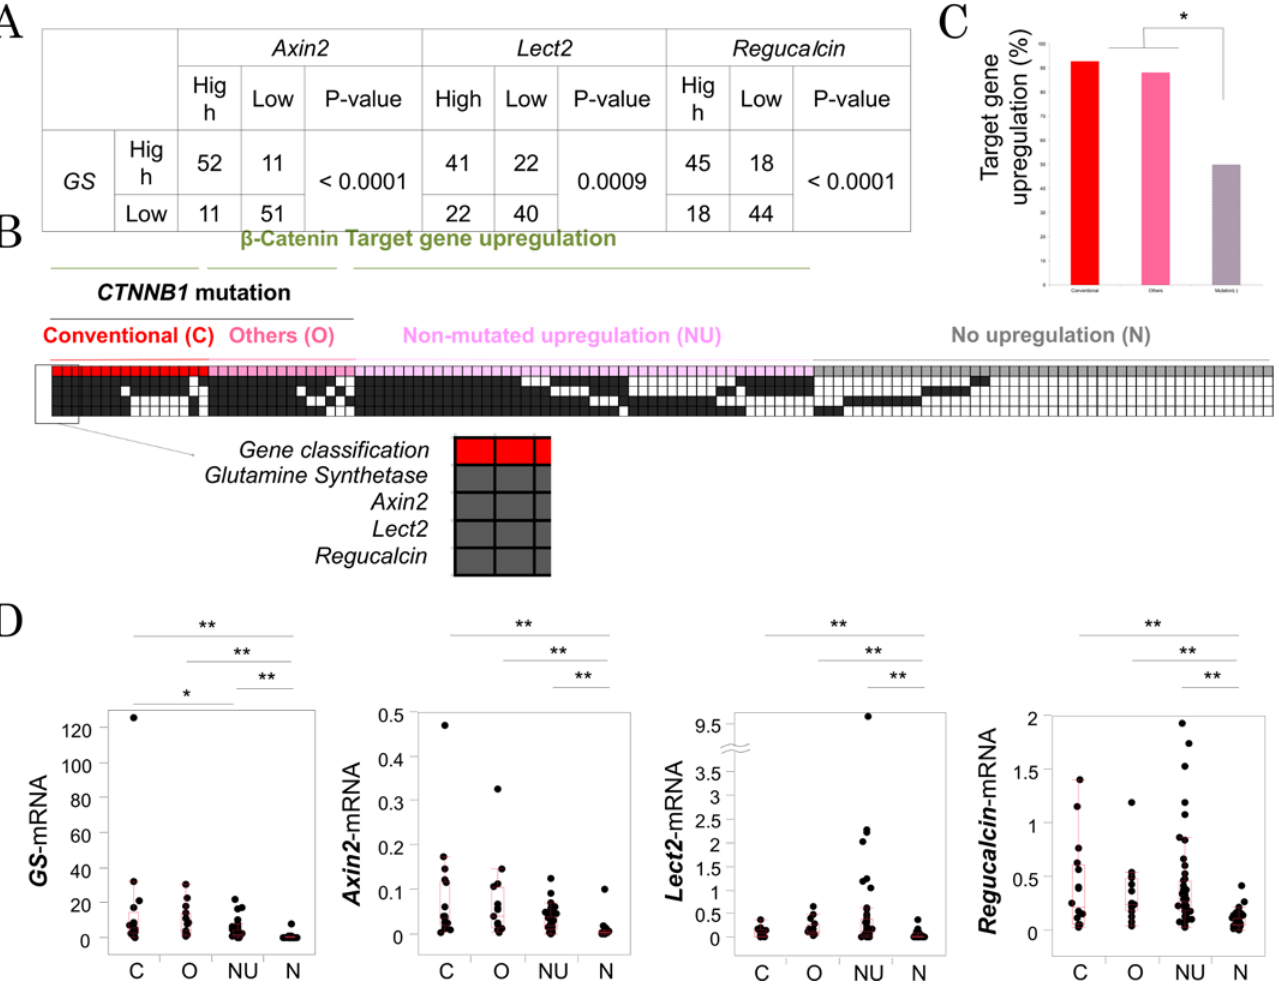
Fig 2. β -catenin signaling based on target gene expressions in human HCC. A. Correlations of β -catenin target gene expressions. B. Heat map is shown based on β -catenin target gene expressions. Patients were classified into 4 groups; patients with conventional mutations (C); patients with other site mutations (O); patients with β -catenin target gene upregulation but no-mutation (NA); patients without mutation or signal activation (N). C. Percentage of β - catenin signal activation is compared among three groups, HCC patients with conventional mutation, patients with other site mutation, and patients without mutations. * p < 0.05. D. quantitative expressions of β -catenin targets, GS , Axin2 , Lect2 , and Regucalcin , are shown. * , p < 0.05. ** , p < 0.01.